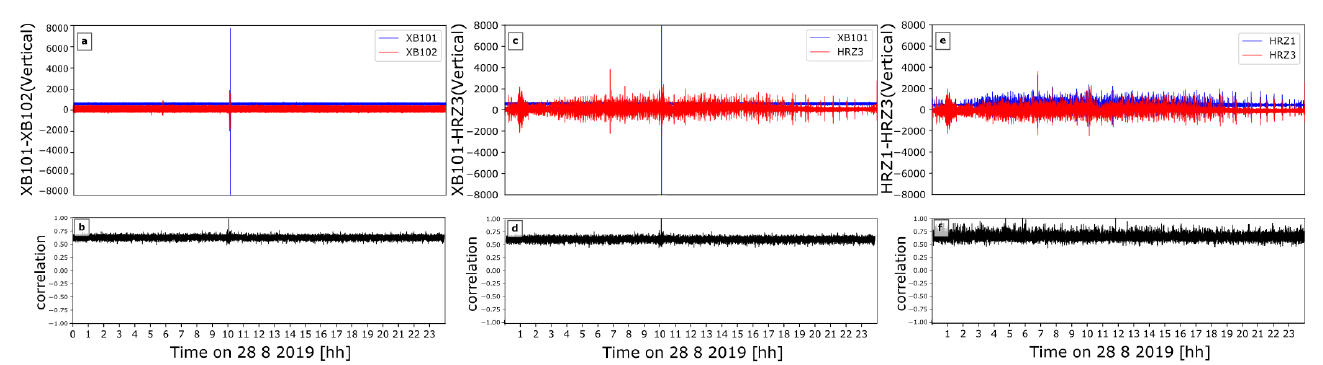
Figure 11. ( a ) Seismograms of XB101 (Blue)—XB102 (Red), ( c ) XB101 (Blue)—HRZ3 (Red), ( e ) HRZ1 (Blue)—HRZ3 (Red) from left to right respectively. Correlation (Black) between ( b ) XB101-XB102, ( d ) XB101-HRZ3, ( f ) HRZ1-HRZ3 sensors for doy 240, i.e., 28 August, Wednesday.